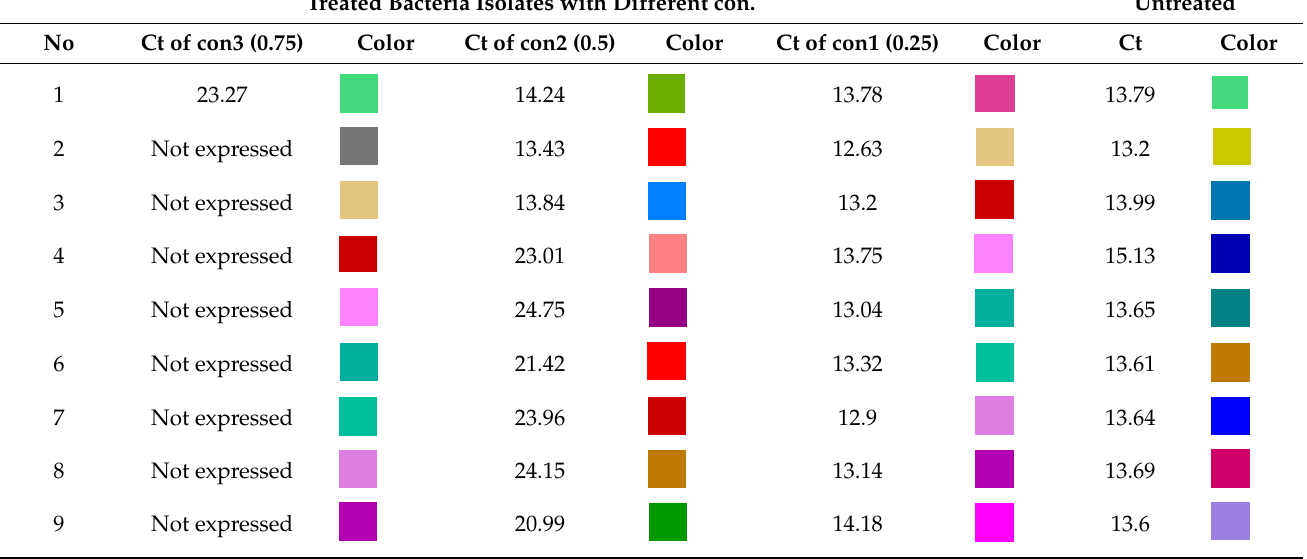
Table 2. magA gene expression in Klebsiella pneumoniae isolates treated with different concentrations of ZnO NPs *. Treated Bacteria Isolates with Different con.